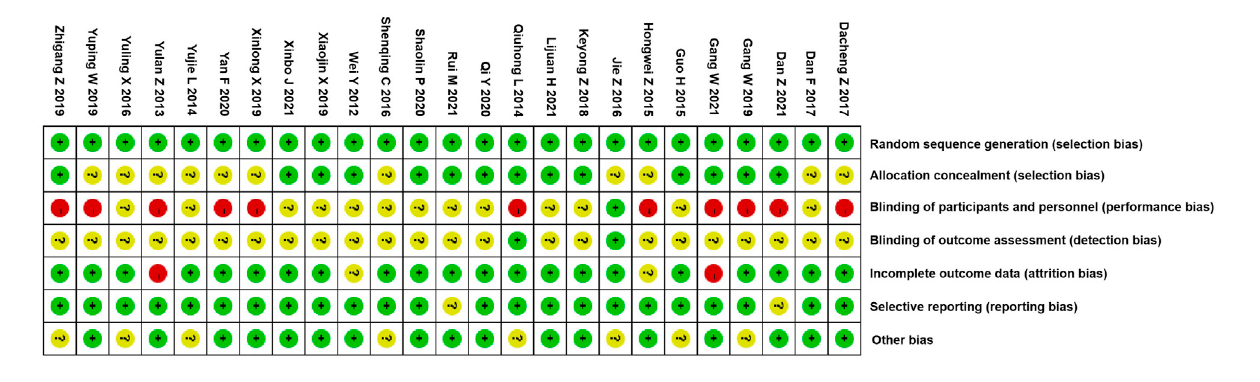
FIGURE 3 Summary of risk of bias based on selection